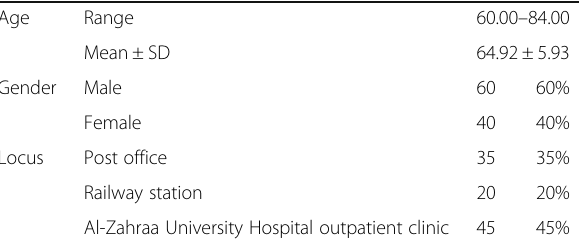
Table 1 Descriptive data of the study groups (100 subjects) in the pretest stage